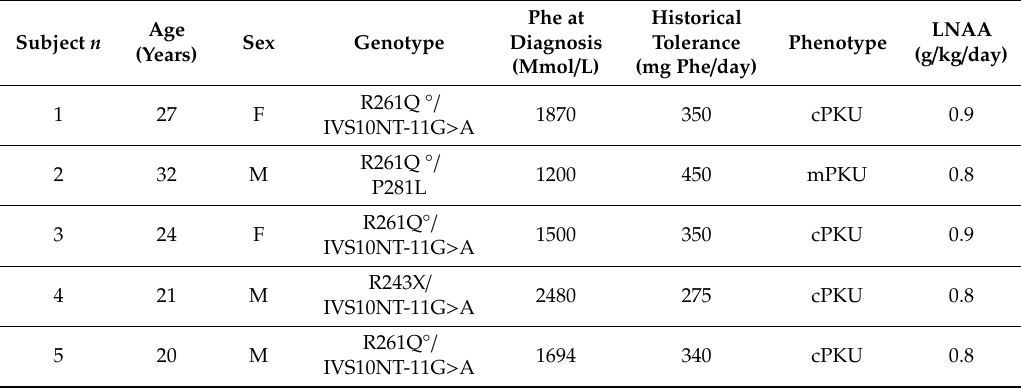
Table 1. Age at enrolment, sex, genotype, phenylalanine (Phe) at diagnosis, historical tolerance, phenotype, and large neutral amino acids (LNAAs) supplementation of the enrolled